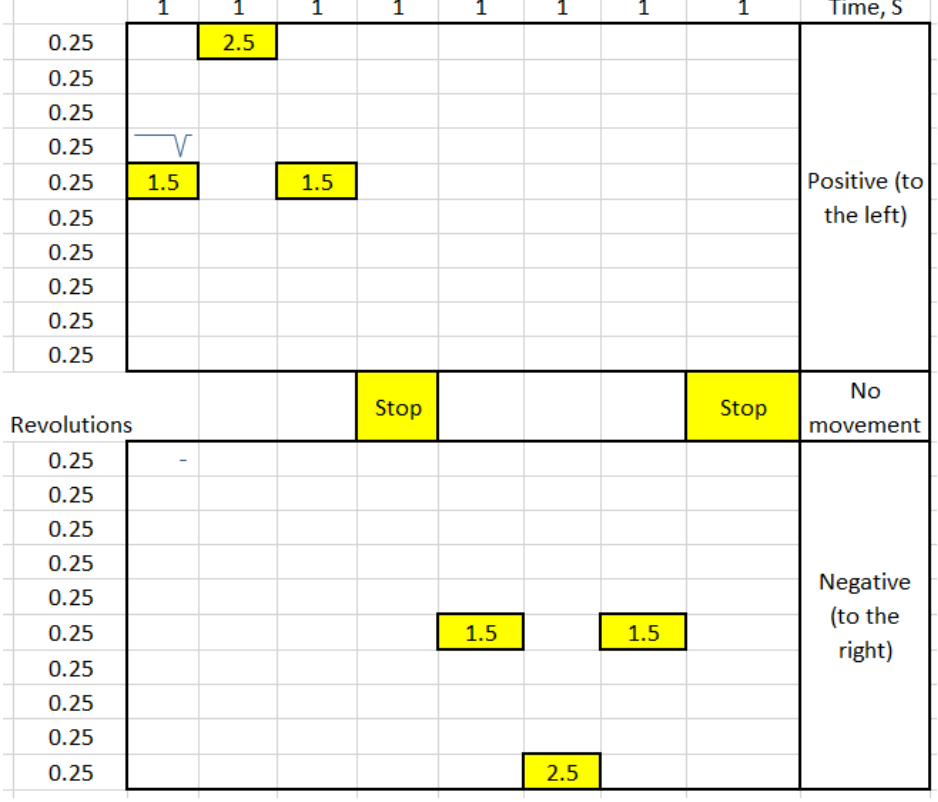
Figure 5. Motor rotation logic.